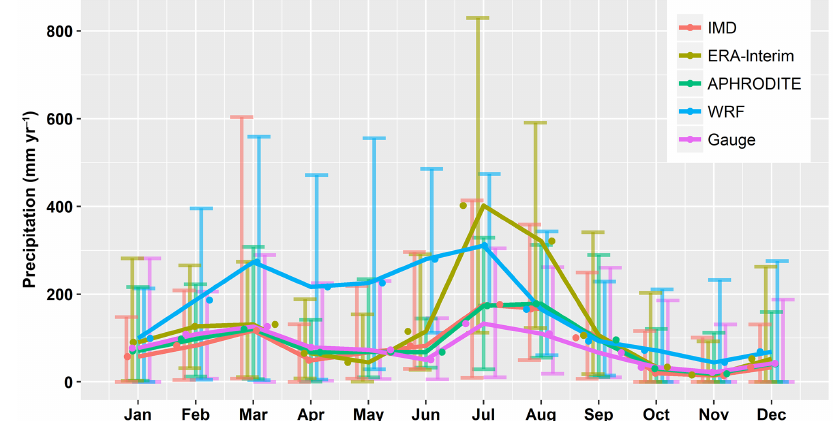
Figure 12. Monthly anomaly at the Bhuntar gauge. Data at the nearest point to the Bhuntar gauge are extracted from the gridded datasets. Table 5. Statistics of annual maximum daily precipitation (mmday − 1 ) at the Bhuntar gauge. Data of the nearest point are extracted from the gridded datasets. Bold indicates the value closest to the data of the Bhuntar gauge.